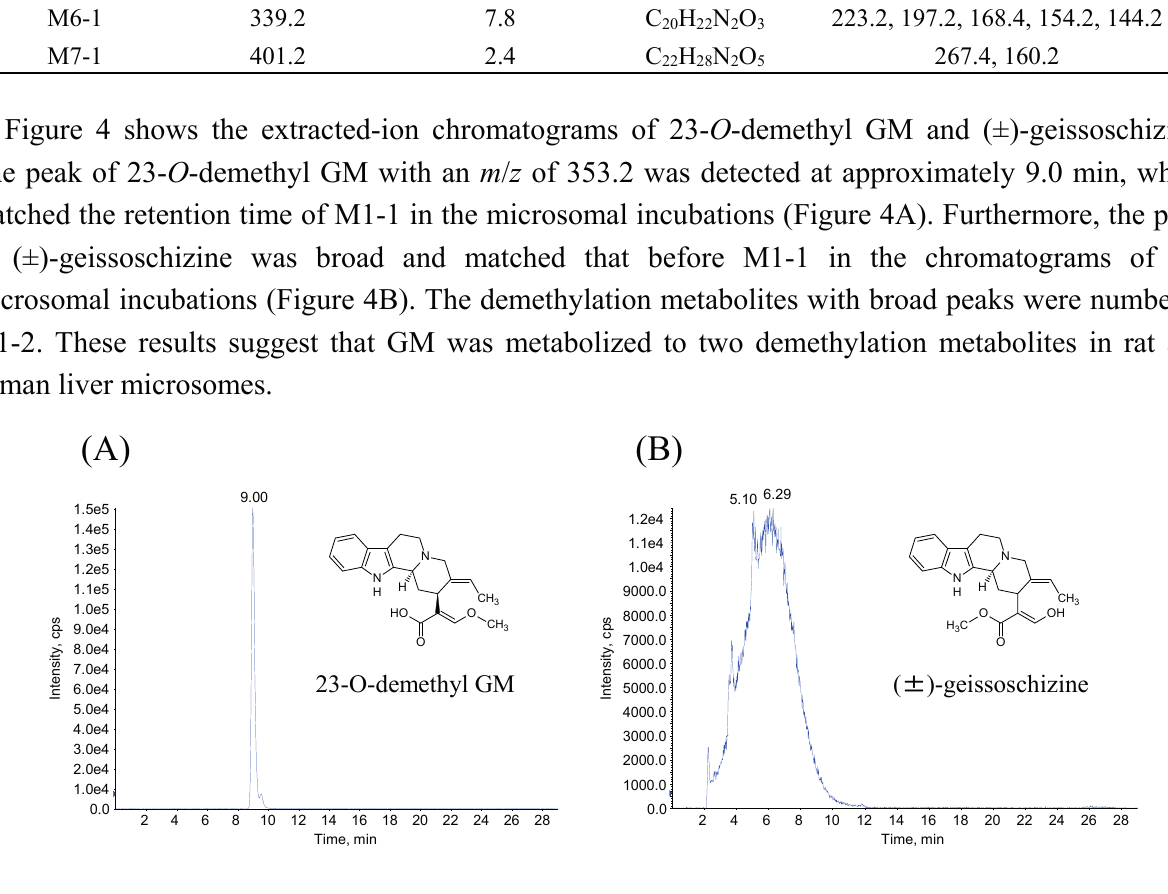
Figure 4. Demethylation metabolites of GM (M1-1 and M1-2). Extracted-ion chromatograms of 23- O -demethyl GM ( A ) and (±)-geissoschizine ( B